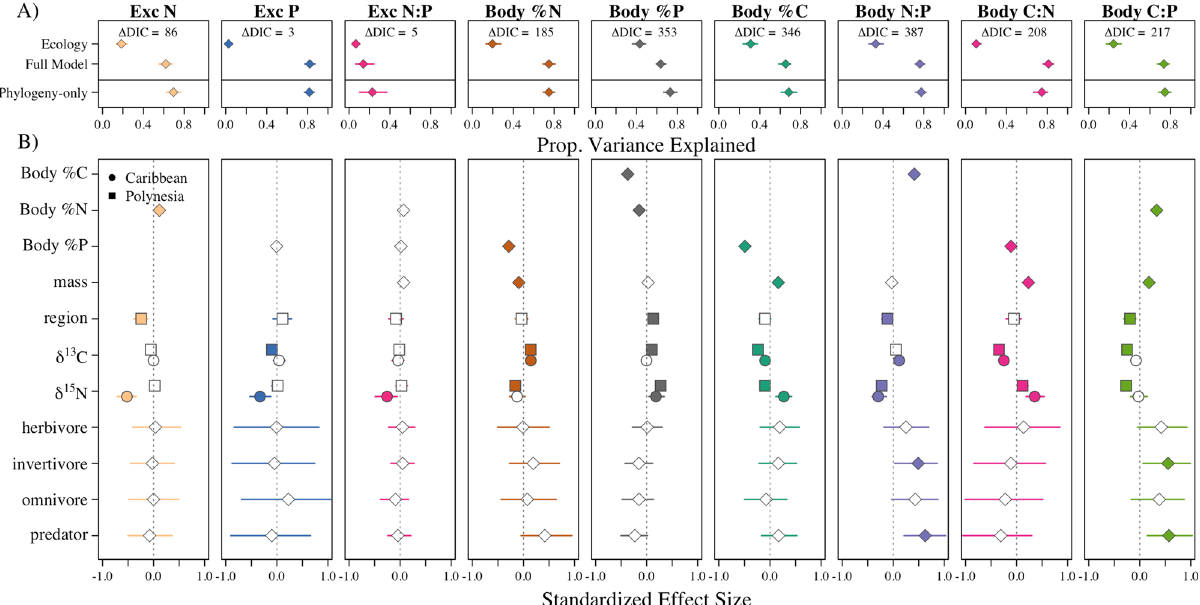
Fig. 1 Phylogenetic relatedness is the best predictor of chemical trait variation in coral reef fi shes. A Variance explained (diamonds) by the “ ecology ” terms in the model ( fi xed effects), the “ full model ” ( fi xed plus random effects), and the “ phylogeny-only ” models for each chemical trait where: “ Exc ” indicated excretion for N, P, or their ratio N:P (molar), and “ Body ” indicates percent C, N, P, and their ratios N:P, C:N, C:P (molar) of dry mass ( n = 1266, 1133, 1123, 1255, 1255, 1255, 1255, 1255, and 1255 individuals, respectively). Error bars indicate 95% Bayesian credible intervals (CIs) associated with model error. Δ DIC indicates the best model with a value >2 showing favor for the full model. B Standardized effect sizes and CIs (diamonds) of all ecology variables in the full model (all fi xed effects). Error bars indicate 95% Bayesian credible intervals (CIs) associated with model error. Body nutrient predictors (e.g., Body %P) are not in all models due to strong covariance among the variables and were chosen as such to test speci fi c hypotheses. Exc N and P are mass-corrected values and thus ‘ mass ’ is not tested in these models — see Supplementary Fig. 1 for models that are not mass-corrected; these models yield equivalent results. Circles indicate estimates for the Caribbean fi shes. Squares indicate estimates for Polynesian fi shes and in the case of ‘ region ’ indicate if the chemical trait signi fi cantly differs from the Caribbean (the model intercept). Filled points indicate the CIs do not overlap with